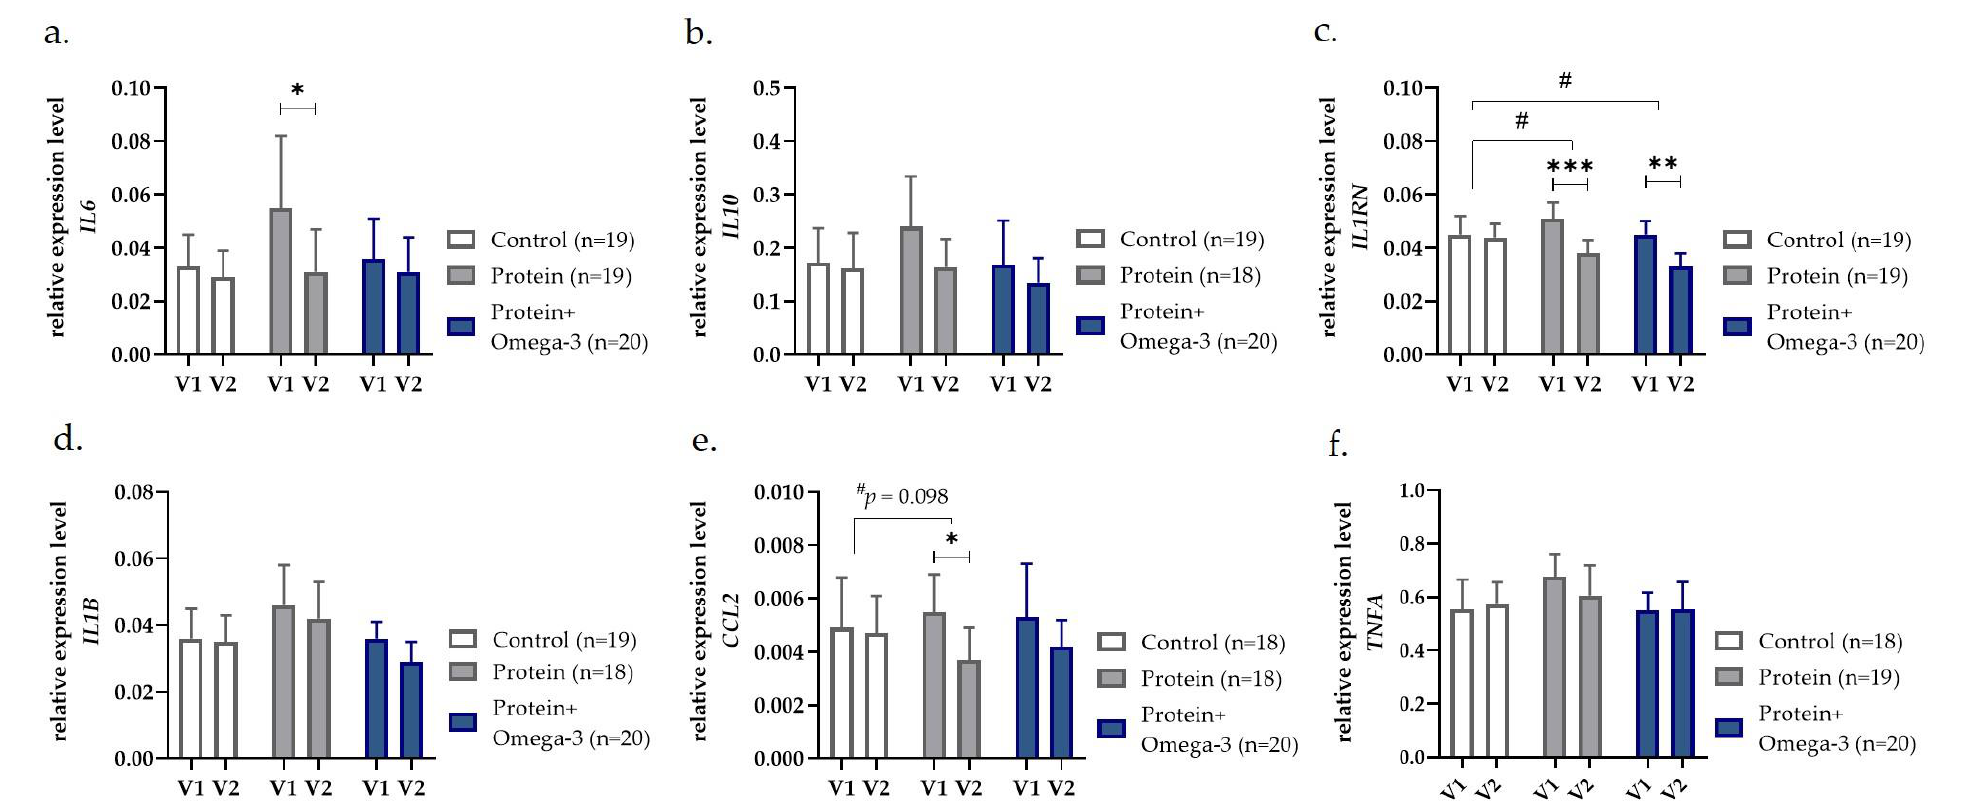
Figure 2. Gene expression levels analyzed in peripheral blood mononuclear cells of ( a ) IL6 , ( b ) IL10 , ( c ) IL1RN , ( d ) IL1B , ( e ) CCL2 , and ( f ) TNFA presented as estimated mean with 95% confidence interval before (V1) and after (V2) eight weeks of control, high-protein (protein) or high-protein, omega-3-enriched (protein + omega-3) diet. * p < 0.05, ** p < 0.01, *** p < 0.001 obtained from within-group comparisons with either paired t -test or Wilcoxon rank test, and # p < 0.05 indicating group × time-interaction effects between groups in generalized linear mixed models with random effects on subjects, adjusted for age, sex, and fat mass index. CCL2 c-c motif chemokine ligand-2; IL interleukin, B beta, RN receptor antagonist; TNFA tumor necrosis factor-α.